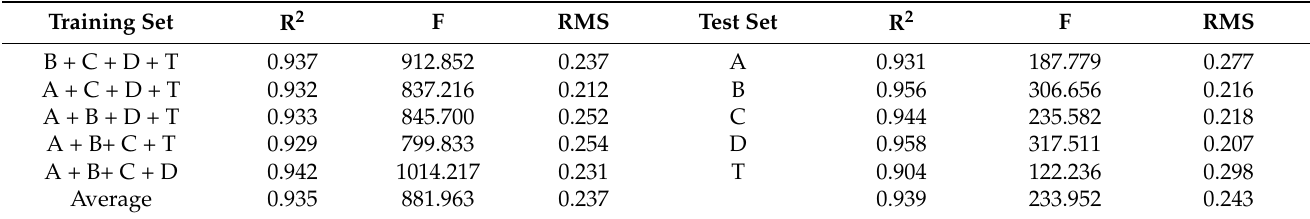
Table 8. Validation of the RBFNN